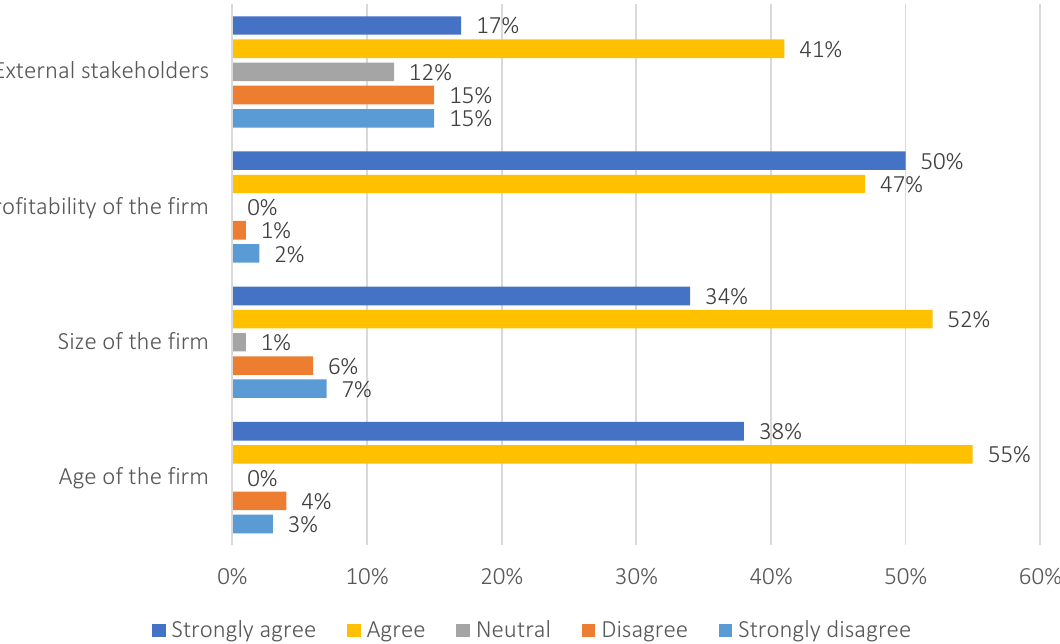
Figure 2. Factors likely to influence firm’s capital